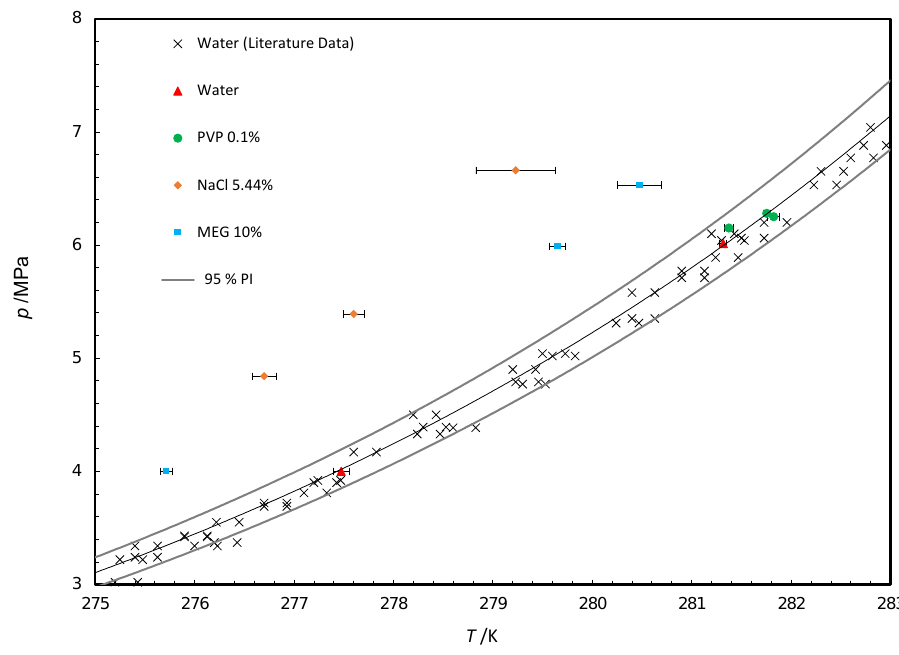
Figure 13. Hydrate-liquid-vapor equilibrium for the system water + CH 4 , water + PVP ( w PVP = 0.1%) + CH 4 , water + NaCl ( w NaCl = 5.44%) + CH 4 , and water + MEG ( w MEG = 10%) + CH 4 . Error bars correspond to standard uncertainty. The black curve is a best fit based on literature data (as compiled in ref [11]) for uninhibited methane hydrate. The gray curves show a 95% prediction interval based on literature data for uninhibited methane